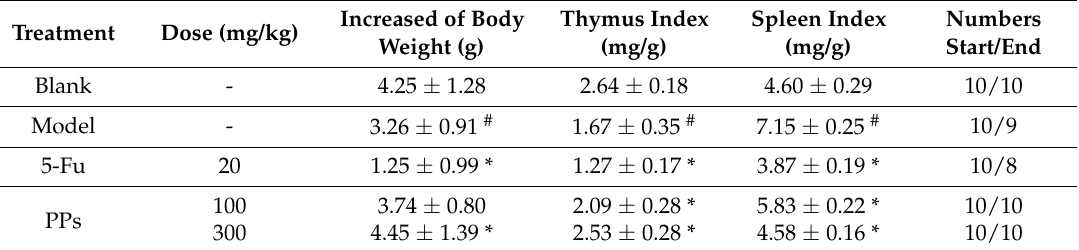
Table 1. Effects of PPs on the body weight, immune organs indexes of S180-bearing mice.